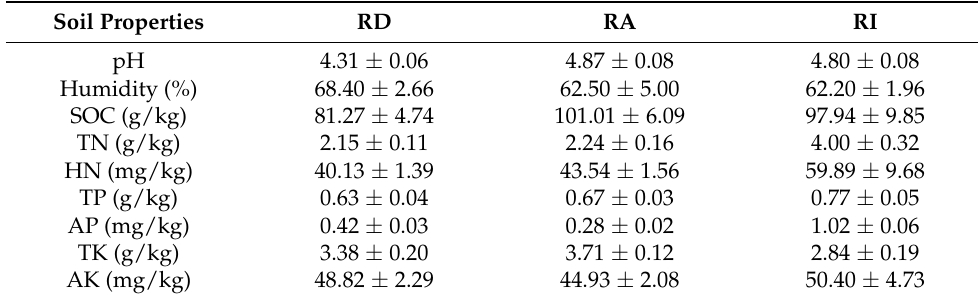
Table 2. Soil properties of the three rhododendron